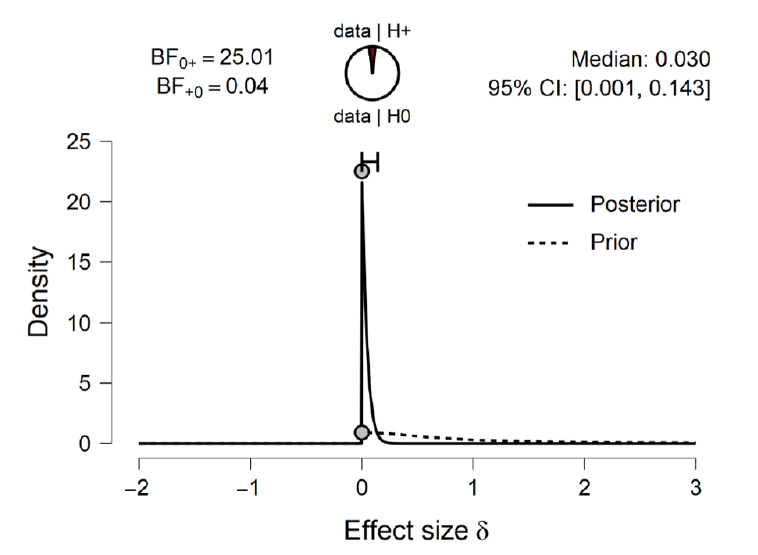
Figure 9. The prior and posterior distribution of the effect size with median and 95% Credible Interval (CI) for the one-sample one-tailed Bayesian t -test test on general accuracy score’s difference from chance level (0.5). The distributions indicate that the effect size d is less likely to be larger than 0 under posterior than